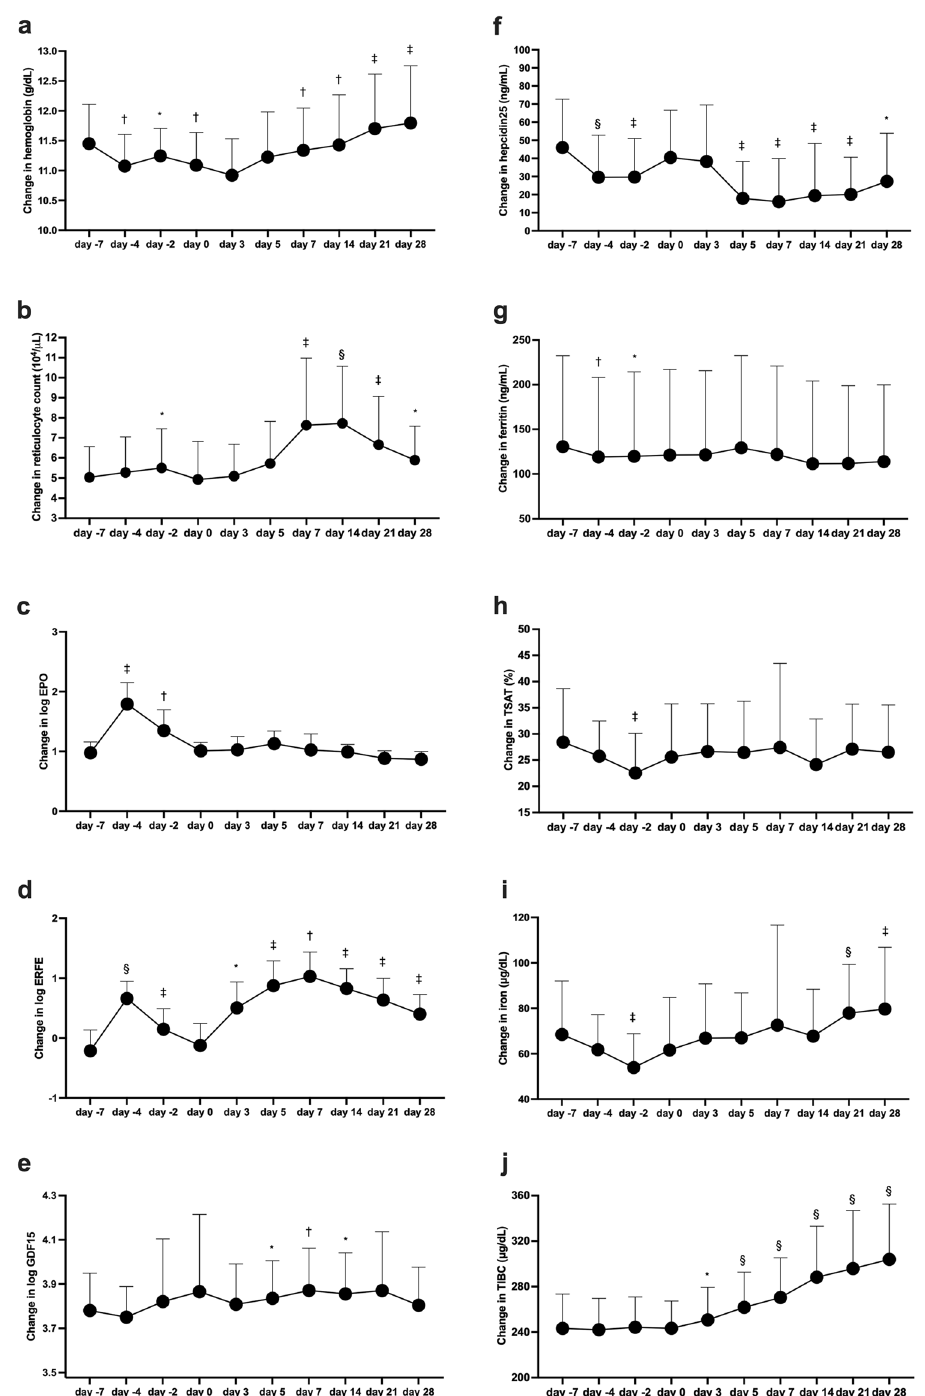
Figure 1. Changes in parameters of erythropoiesis and iron metabolism by darbepoetin-α treatment and roxadustat treatment. Changes in levels of hemoglobin ( a ), reticulocyte counts ( b ), erythropoietin (EPO) ( c ), erythroferrone (ERFE) ( d ), growth differentiation factor 15 (GDF-15) ( e ), hepcidin-25 ( f ), ferritin ( g ), transferrin saturation (TSAT) ( h ), iron ( i ), and total iron binding capacity (TIBC) ( j ). Darbepoetin-α (DA) is injected at day − 7, and roxadustat supplementation is started from day 0. Data during DA treatment are compared between the value at day − 7 and the target value, and data during roxadustat treatment are compared between the value at day 0 and the target value. Data are shown as means ± standard deviation. *p < 0.05, † p < 0.01, ‡ p < 0.001, § p <